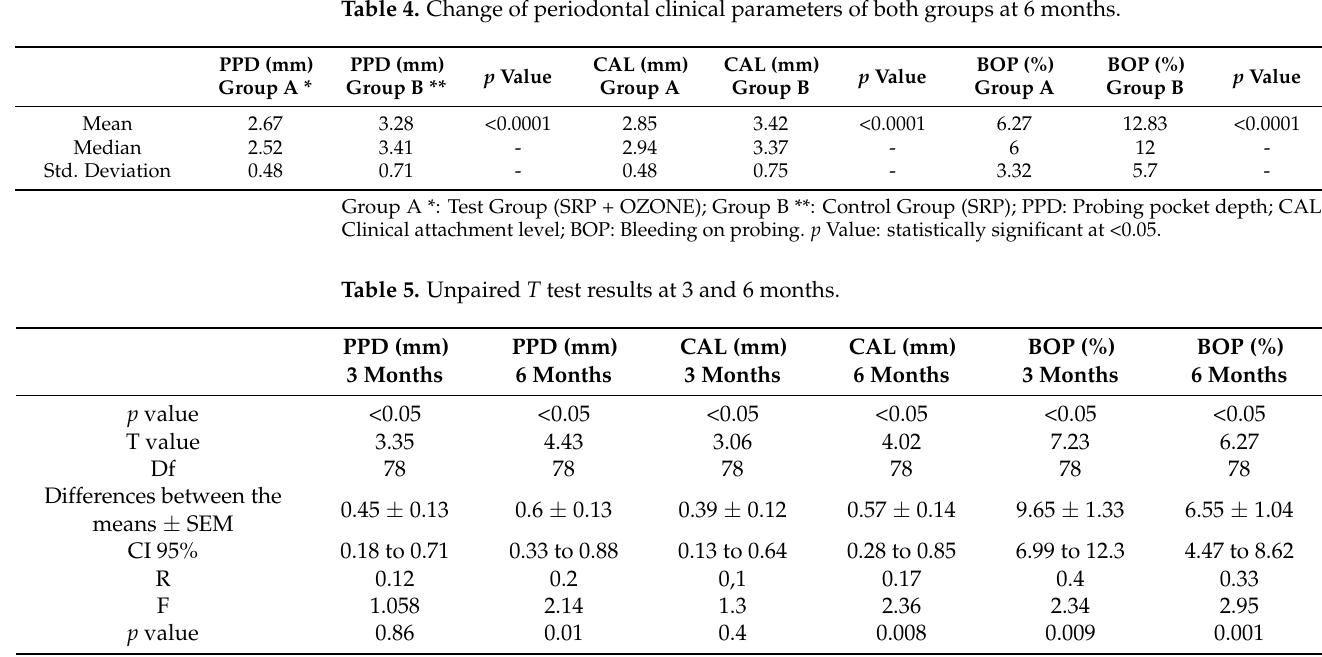
Table 4. Change of periodontal clinical parameters of both groups at 6 months.